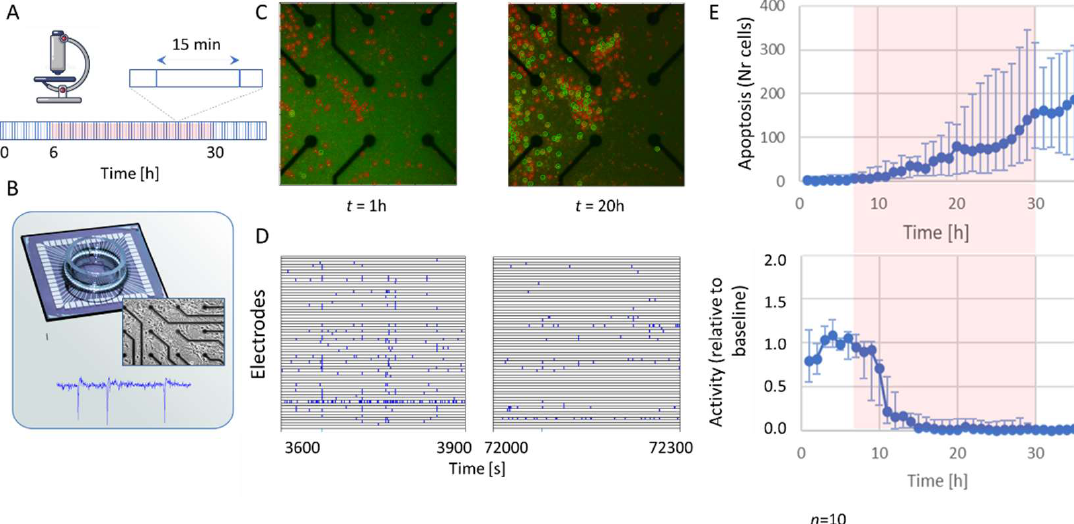
Figure 1. Simultaneous assessment of electrophysiological activity and apoptosis in neuronal cultures exposed to hypoxia. ( A ) Experimental protocol: fluorescent images were taken from rat cortical cultures stained for apoptosis and cell death every 15 min during baseline (normoxia; 6 h), hypoxia (10% of normoxia; 24 h, indicated by red-shaded background), and after reoxygenation (normoxia; 6 h). ( B ) Micro-electrode Array (MEA) system for recording of electrophysiological activity. Insets show a phase-contrast image of cells on the MEA and an example of a recorded signal. ( C ) Example photographs of a culture stained for apoptosis (green) and cell death (red), taken at 1 h (left; baseline), or 20 h (right; hypoxia). Apoptotic and dead cells were automatically detected and counted by a custom computer algorithm (green and red circles). ( D ) Examples of 5 min of recorded activity after 1 h (left; normoxia) or 20 h (right; hypoxia). Vertical axes show traces of the 60 electrodes, all blue ticks represent action potentials. Hypoxia greatly reduced the amount of action potentials and synchronicity. ( E ) Median temporal evolution of apoptosis (upper) and activity (lower panel) in 10 cultures. Error bars represent 25% and 75% percentiles.